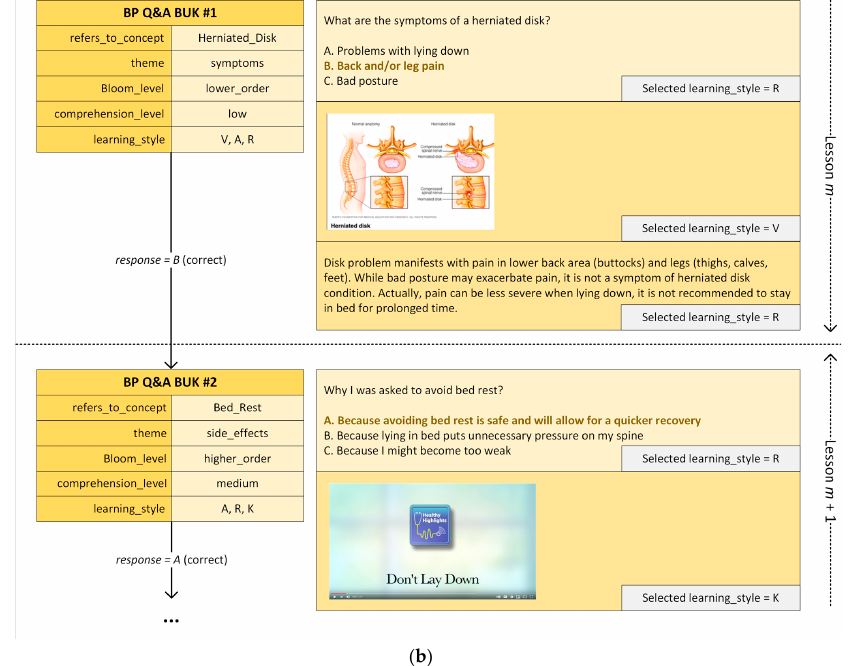
Figure 6. Selected lesson fragments for the two use cases: ( a ) anticoagulation treatment associated with AF and ( b ) lower back pain management required for treating lumbar degenerative disc condition. Table 3. Interactions between Anne and the framework in the lower back pain use case (low comprehension level, preferred learning style: K and V). For the identifiers of Q&A and Content BUKs refer to Figure 6b. Interaction